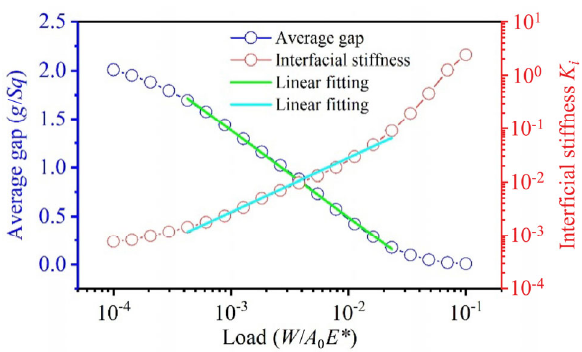
Fig. 8 Average gap as a function of